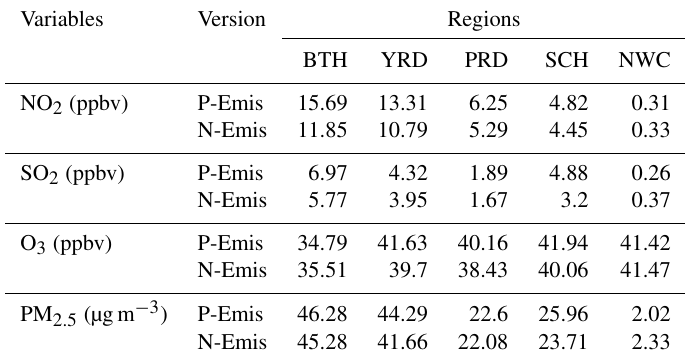
Table 4. The 4-month average concentrations of NO 2 , SO 2 , O 3 and PM 2 . 5 in five typical regions using different emission inventories.